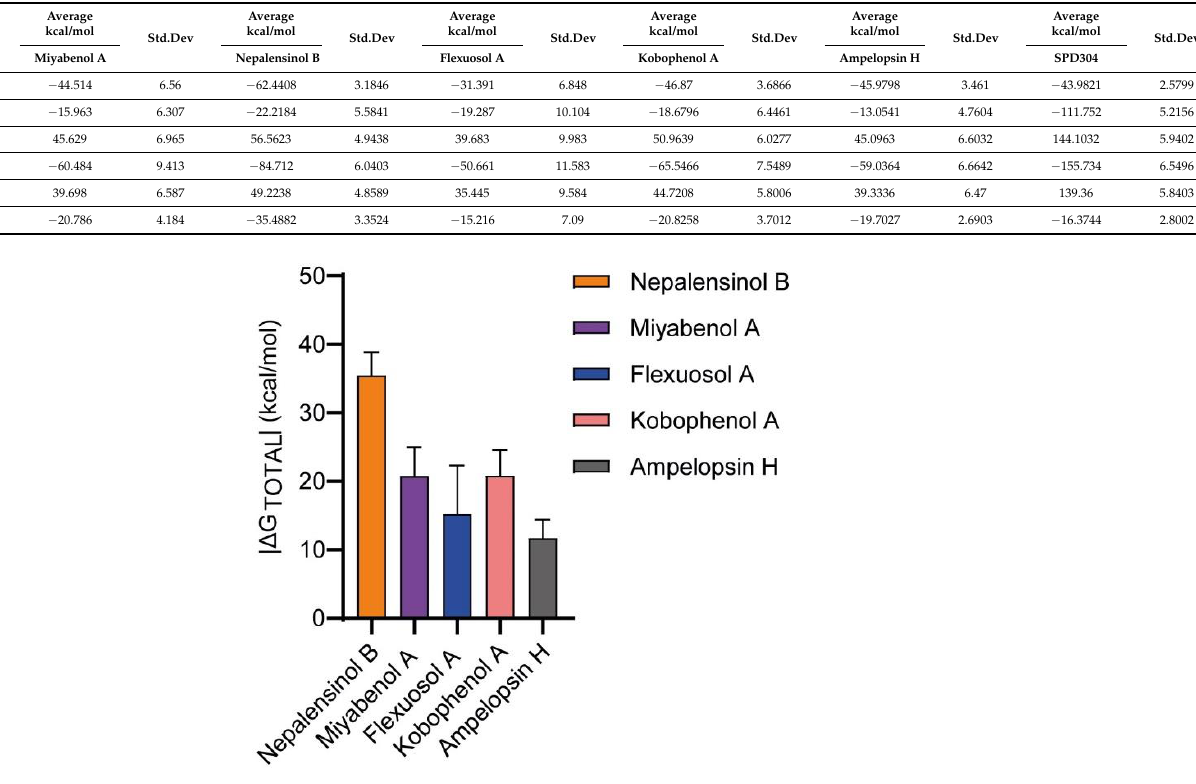
Figure 7. Histogram of the | Δ G total| values produced by MM-GBSA calculations. Nepalensinol B is characterized by the best binding affinity (~ − 35 kcal/mol), 10 kcal/mol approximately higher than the other ligands. Noteworthy is the | Δ G| value of the Ampelopsin H, which is characterized by the lowest binding affinity.